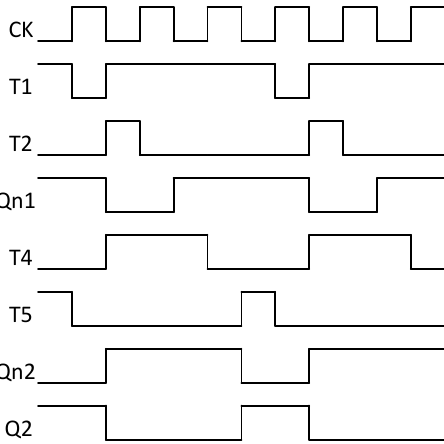
Figure 4. Waveforms of the proposed prescaler in divide-by-3 mode.